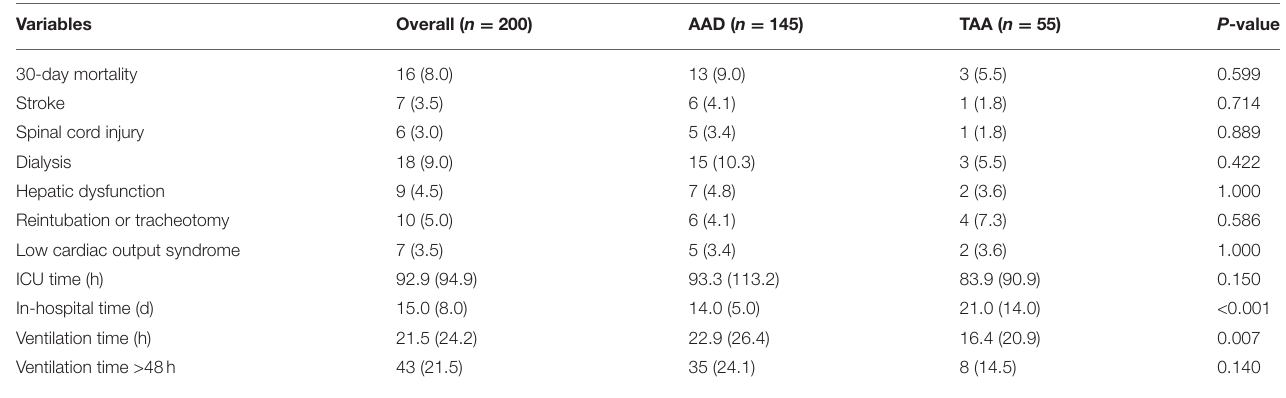
TABLE 3 | Early postoperative